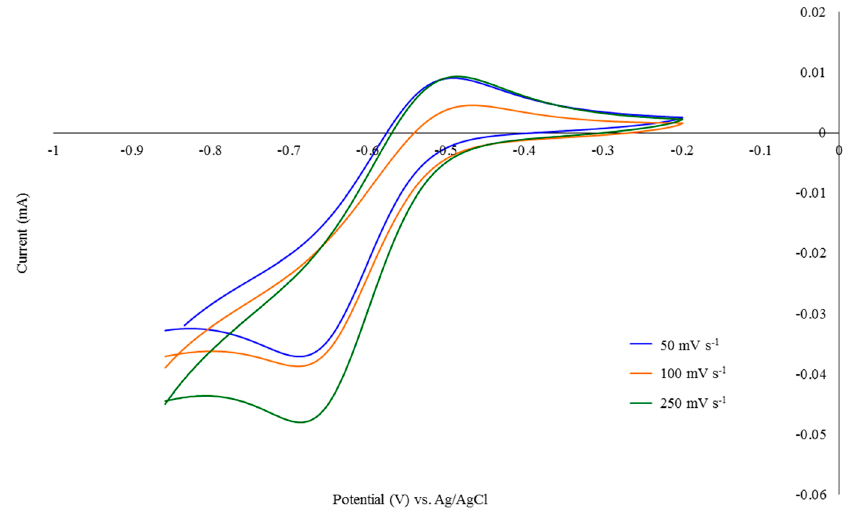
Figure 1. Cyclic voltammagrams of compound 4 in CH 3 CN (0.1 M tetrabutylammonium perchlorate (TBAP)) recorded at scan rates of 50, 100 and 250 mV s − 1 at a glassy carbon electrode at 20 °C.